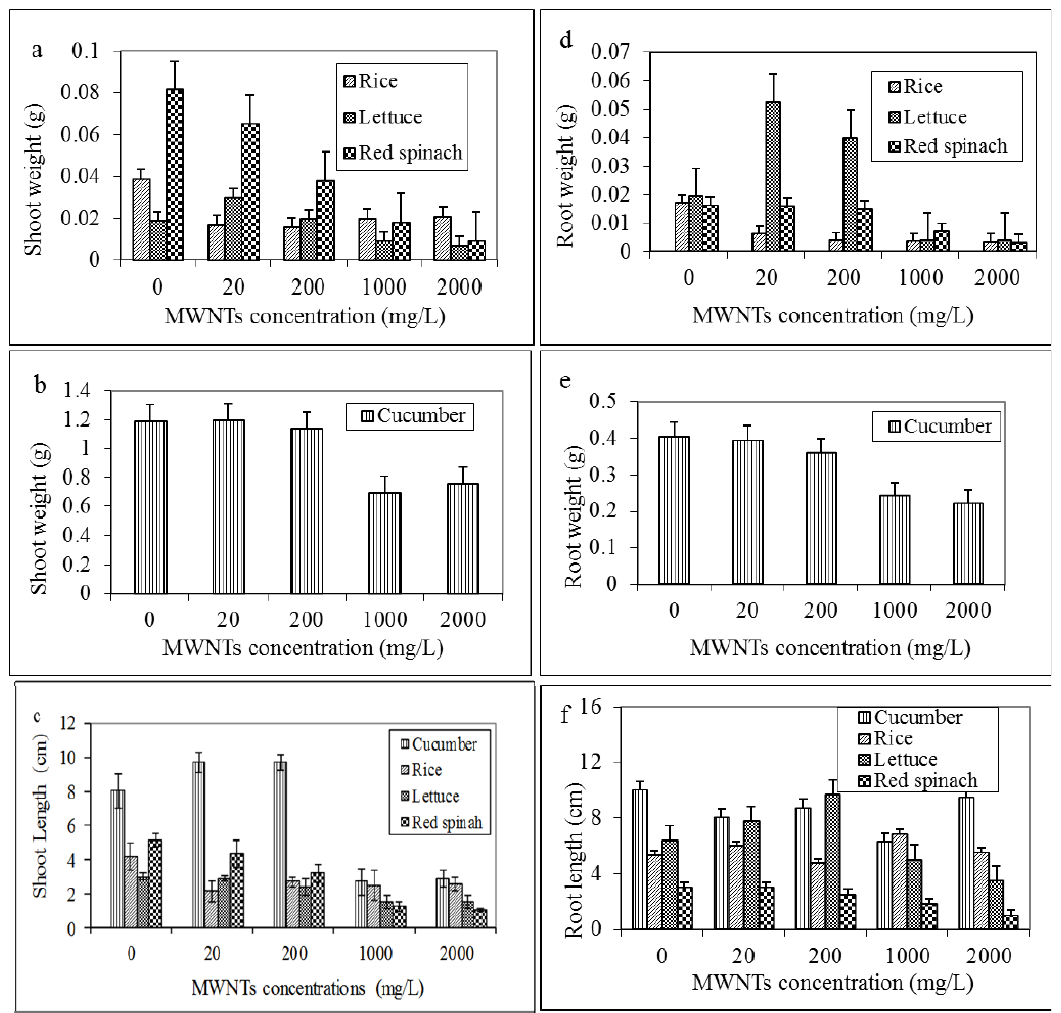
Figure 3. Growth reduction of red spinach, lettuce, rice, and cucumber after 15 days of exposure to MWNTs. ( a , d ) Shoot and root weights, respectively, of red spinach, lettuce, and rice. ( b , e ) Shoot and root weights, respectively, of cucumber. ( c , f ) Shoot and root lengths, respectively, of red spinach, lettuce, rice, and cucumber. Error bars represent standard deviation of the mean ( n = 3). The cucumber data are presented separately because the shoot and root fresh weights were larger than for the other tested plants. Reproduced with permission from reference [16], Copyright 2012,